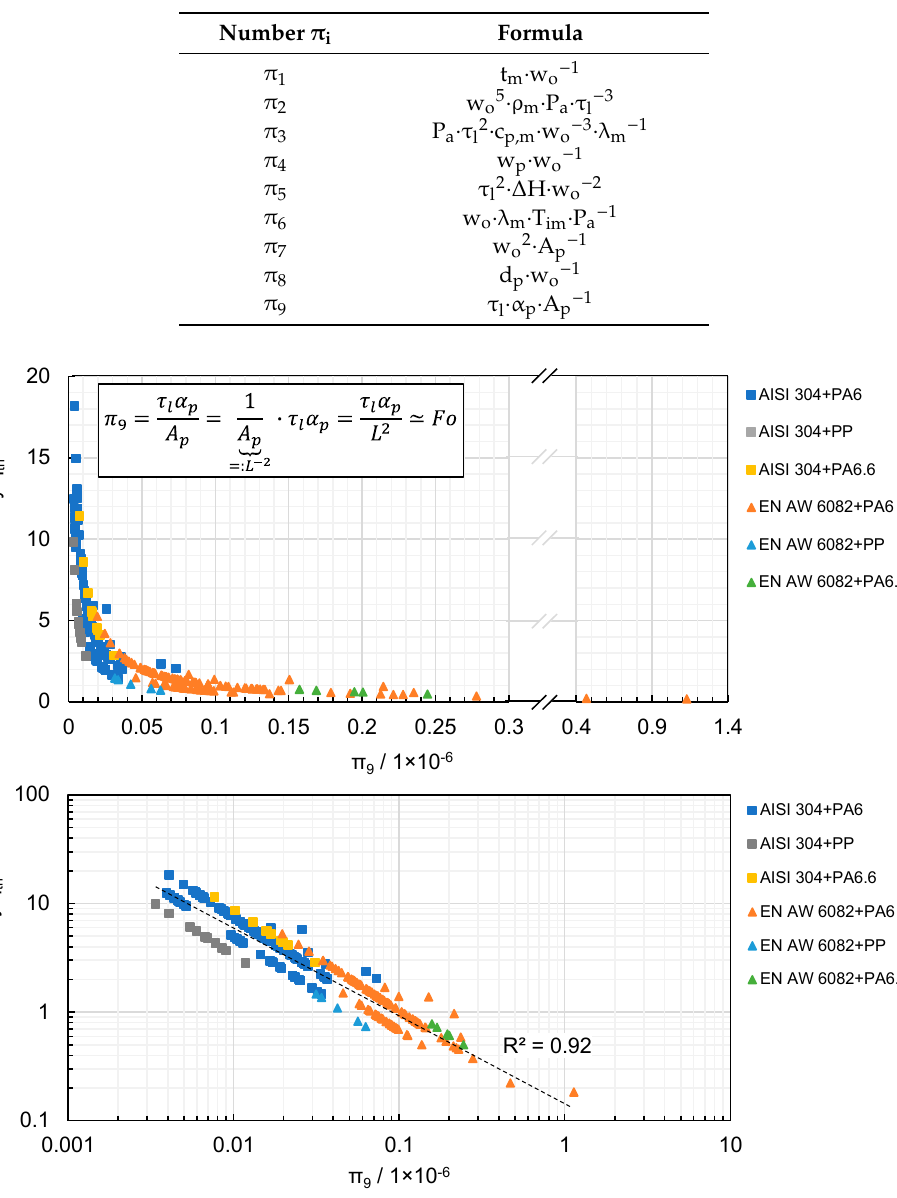
Table 3. Calculated dimensionless numbers π i .